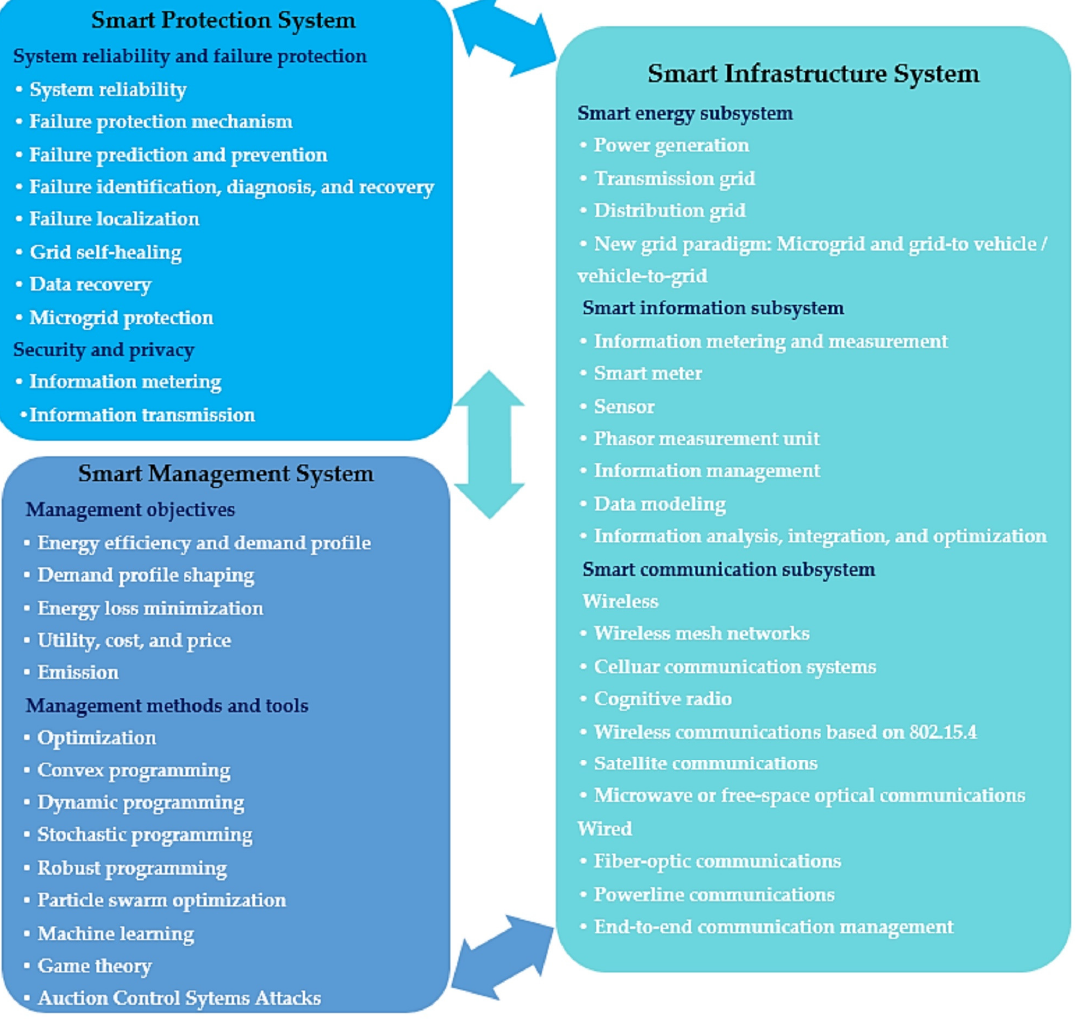
Figure 2. SG Cyber-Security System Structure and Relationship